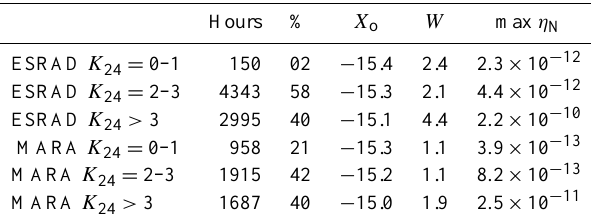
Table 2. Details corresponding to the histograms and fitted curves in Fig. 5. First column lists the different conditions corresponding to the different histograms, second column the number of hours of observations available in each category. Third column gives the % of observations belonging to each category. The fourth and fifth columns list the parameters of the fitted lognormal distribu- responding to dashed curves in the figure. The final column lists the maximum volume reflectivity observed in each